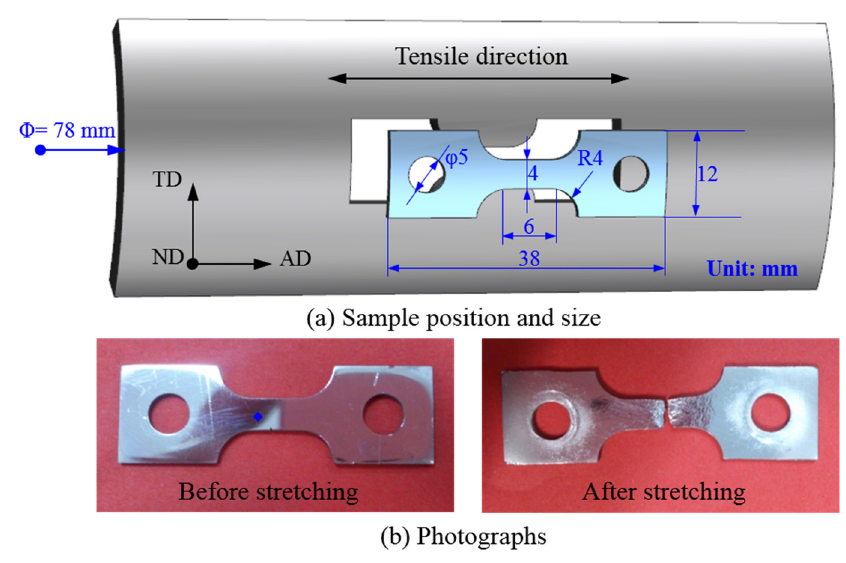
Figure 2. ( a ) Sample position and size. ( b ) Photographs of quasi ‐ in situ sample.